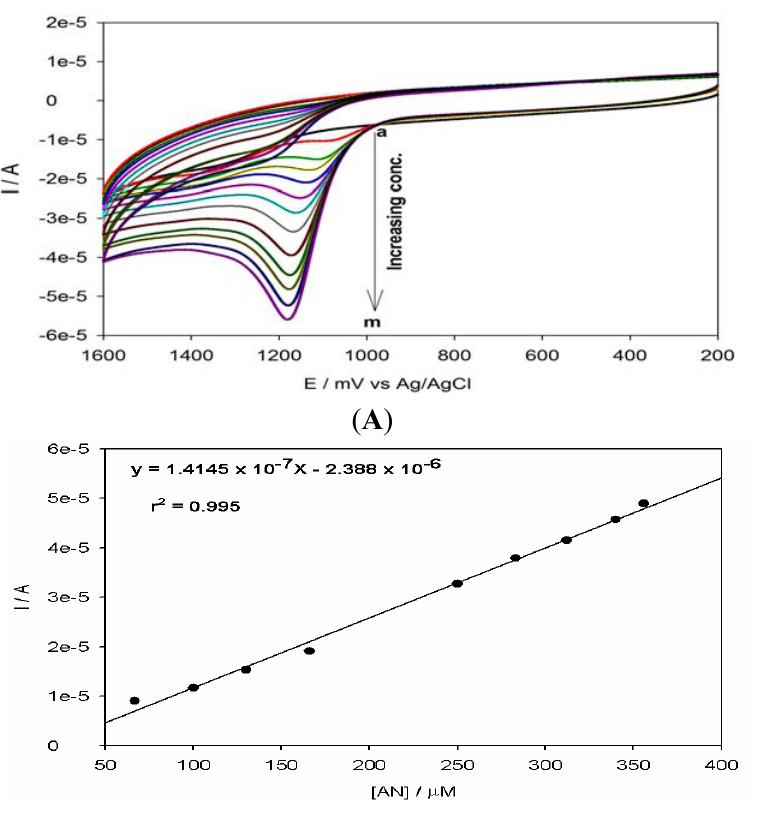
Figure 9. (A) CV of PPyox/Ag-AuNPs/GCE in acetonitrile +0.1 M LiClO anthracene concentration: (a) 0, (b) 33, (c) 66, (d) 100, (e) 133, (f) 166, (g) 200, (h) 233, (i) 250, (j) 283, (k) 312, (l) 340, (m) 356 µM at a scan rate of 100 mV s − 1 and ( B ). A calibration plot showing the relationship between oxidation current and concentration of